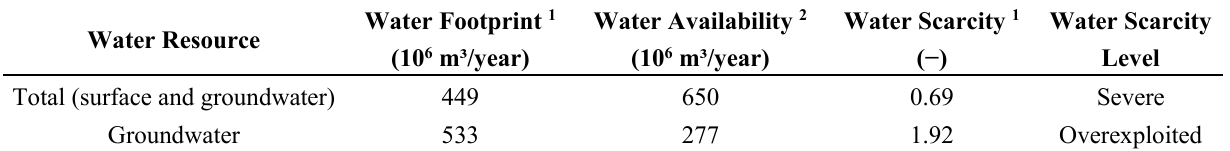
Table 3. Blue water scarcity in Jordan regarding total runoff and groundwater only.